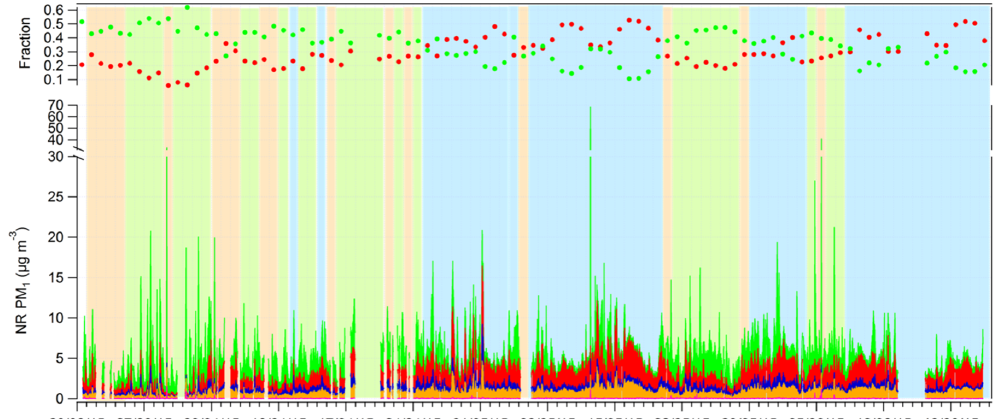
Figure 6. (Bottom) IOP-1 stacked time series of OM (green), SO 4 (red), NO 3 (blue), NH 4 (orange) and Chl (pink) on an ACSM time step (30min) and (top) daily averaged fraction of OM and SO 4 . Tinted areas correspond to continental days (in light pink), sea breeze days (in light green) and marine days (in light